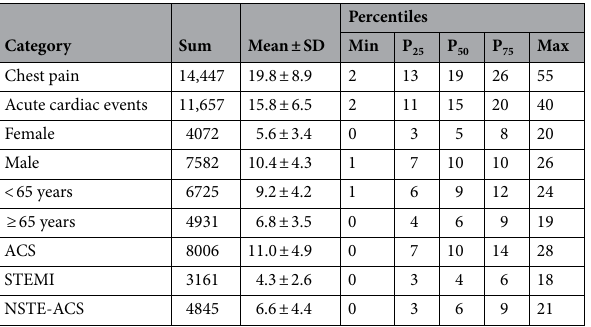
Table 1. Summary statistics of daily hospital admissions between 1st March 2017 and 28th February 2019. ACS, acute coronary syndrome; STEMI, ST-segment-elevation myocardial infarction; NSTE-ACS, Non-STEMI acute coronary